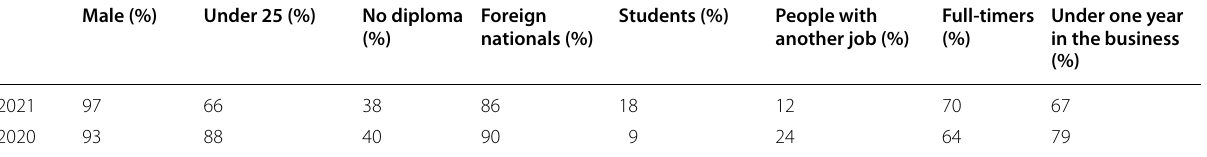
Table 1 General characteristics of the couriers in 2020 and 2021. Source : Author’s surveys Male